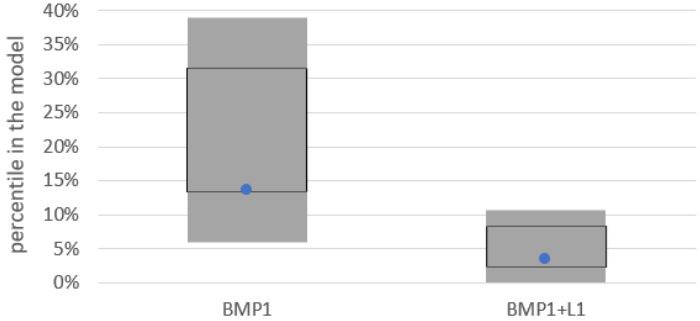
Figure 13. Comparison of the implied percentiles for the backtesting exercise; representation based on own results (blue dots) and EIOPA (2021a, pp. 19–20) (gray boxes). As displayed in Table 1, for all portfolios, α P , GAN for the GAN-based model is above 0.5%, which is in line with the EIOPA expectations mentioned above. Table 1. Worst case losses of all benchmark portfolios and implied percentiles of the GAN-based model. Benchmark